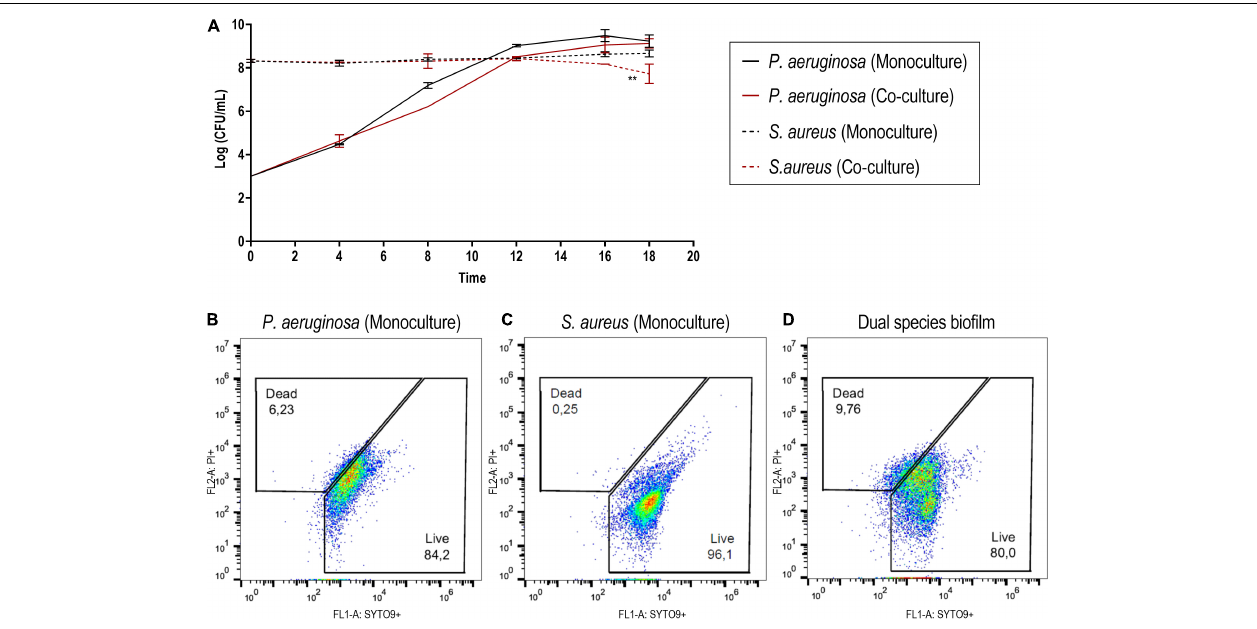
FIGURE 2 | (A) Monitoring of the bacterial density of Staphylococcus aureus ATCC 25923 and Pseudomonas aeruginosa PAO1 in mono- and co-cultured biofilms at different time points. (B–D) Cytographs corresponding to cells recovered from the biofilm formed by P. aeruginosa (B) and S. aureus (C) in monoculture and the dual-species biofilm (D) . SYTO 9 was used to stain viable cells, while PI was utilized to stain cells with disrupted cell membrane integrity. The results are expressed as the mean of at least two biological repetitions with their ± SD. Statistical differences were assessed by comparing the mono- and co-cultured biofilms of each bacterial species (Student’s t -test, ∗∗ p < 0.01).